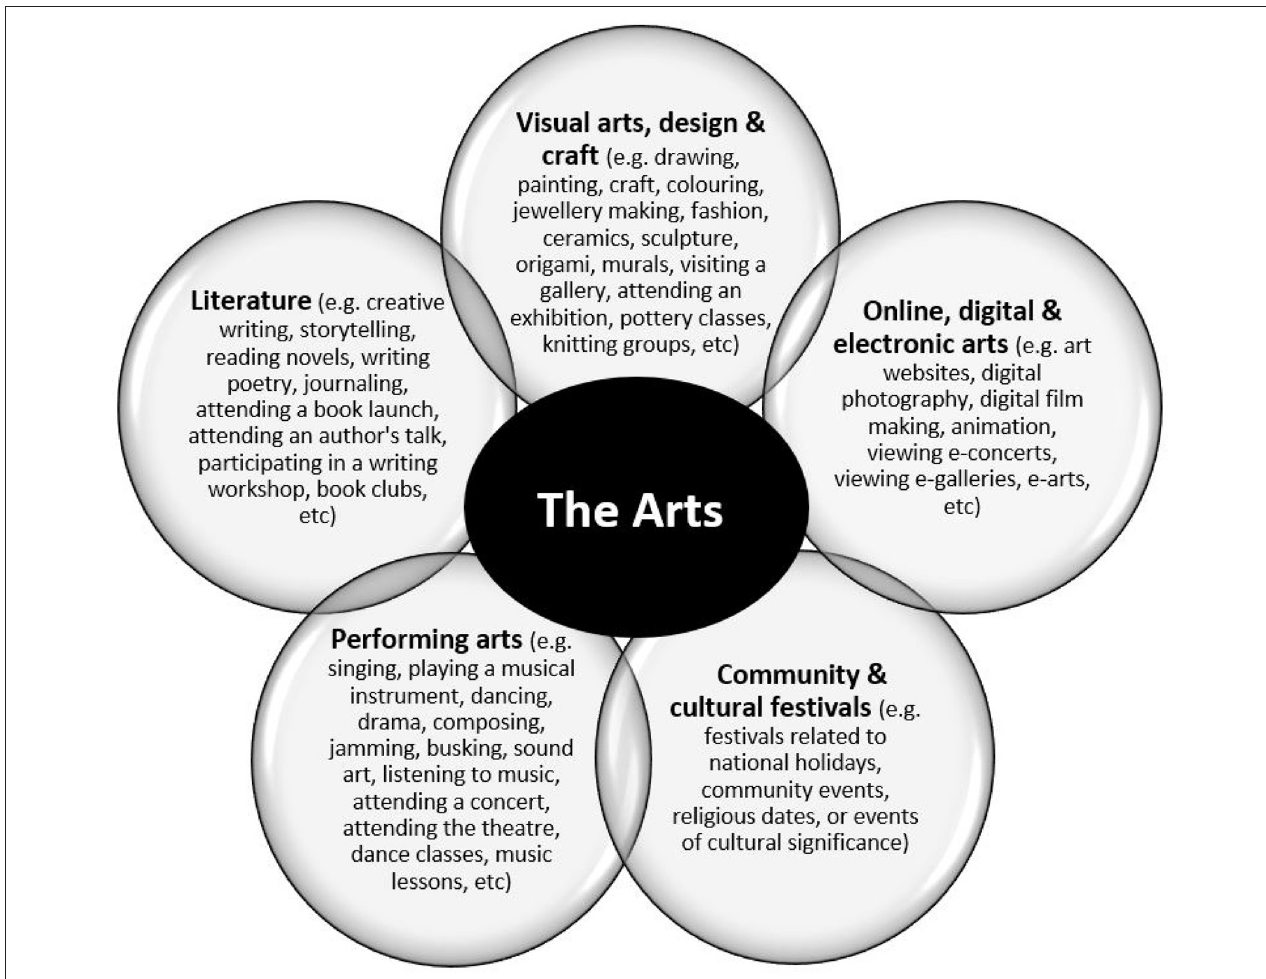
FIGURE 1 | Art forms, activities and events (adapted with permission, Davies et al.,